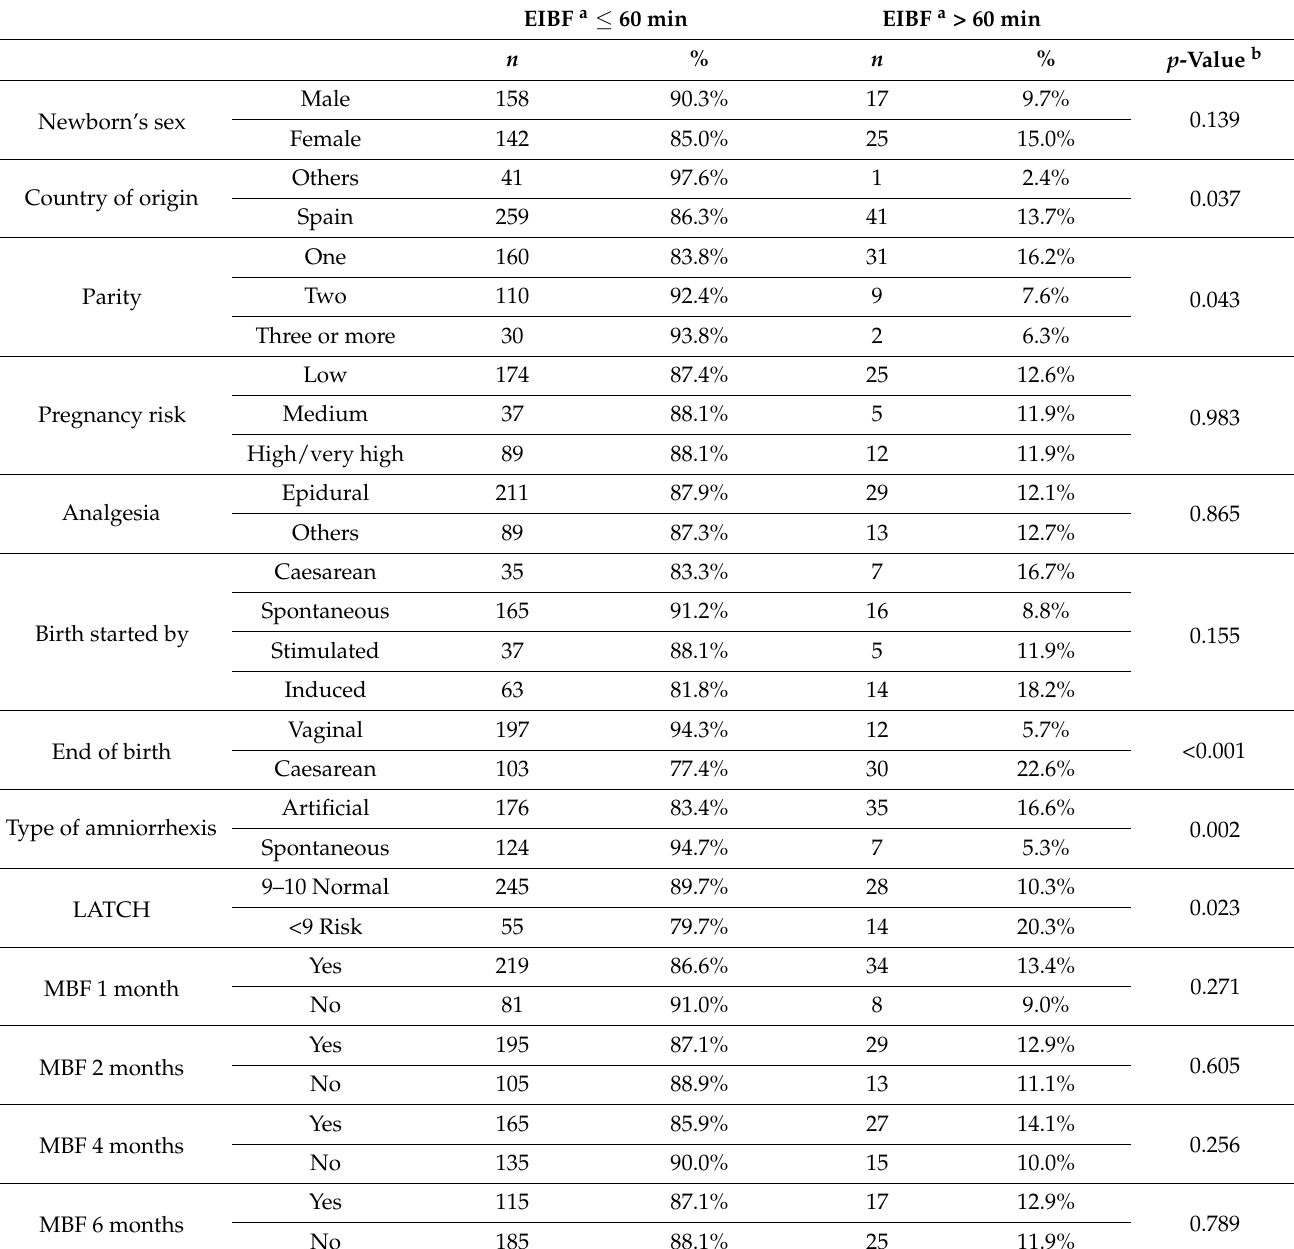
Table 2. Relation between early latching and the other variables ( n =